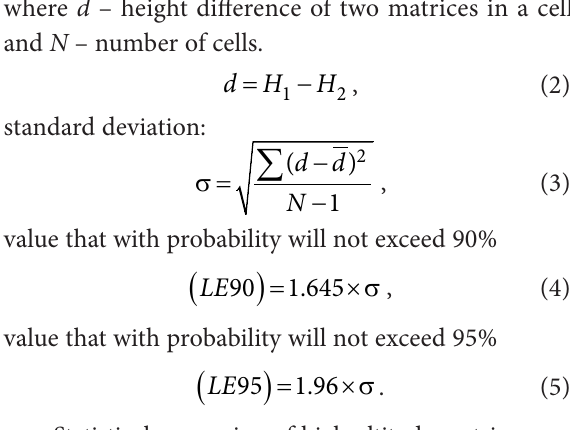
23.41Table 2. The statistical parameters of difference between height matrix ASTER and height matrix SRTM Relief type Plain Hilly